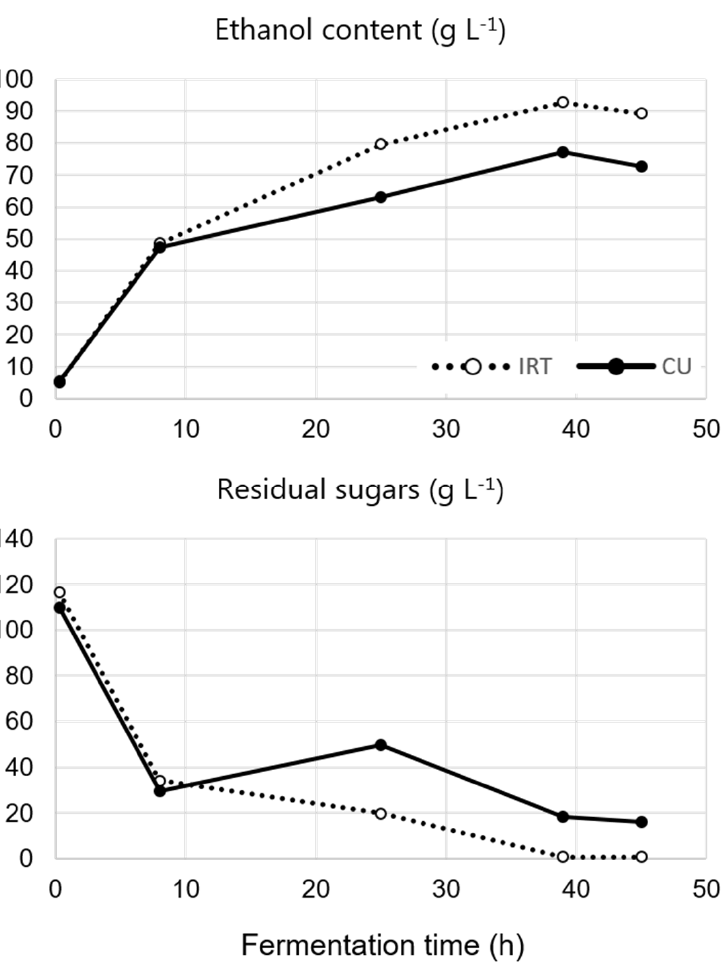
Figure 2. Ethanol content and residual sugars for both treatments (IRT—ionizing radiation treated; CU—contaminated untreated) at different fermentation times in Study 2.